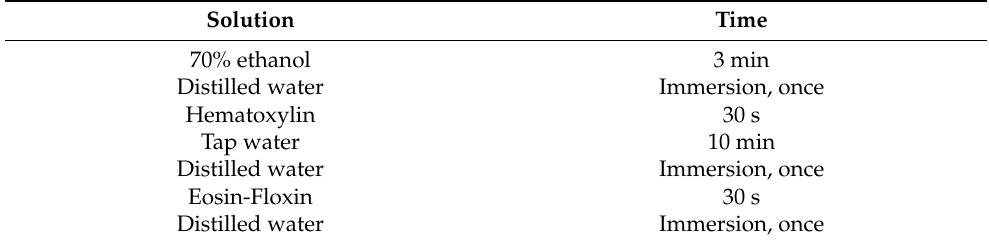
Table 5. H&E staining of sections in